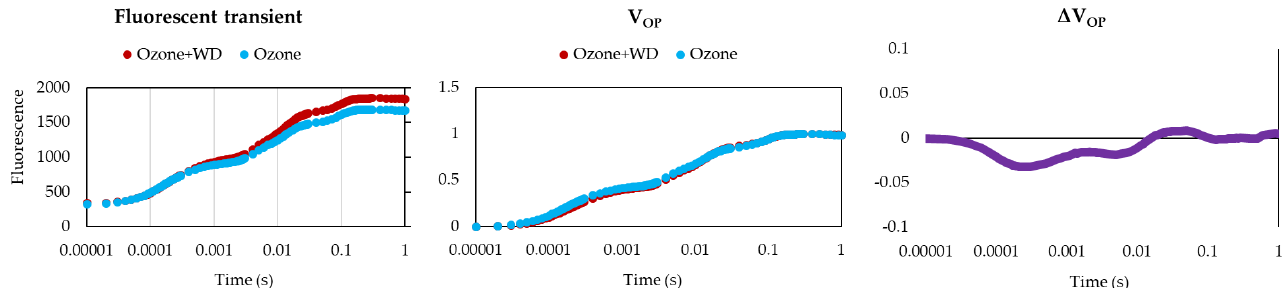
Figure 1. Average log-probit OJIP fluorescence curves and V OP analysis of samples of Lactuca sativa after 30 days of fumigation with 60 ppb of O 3 in combination with (Ozone + WD) or without (Ozone) weekly foliar applications of 0.2% chestnut wood distillate (WD).